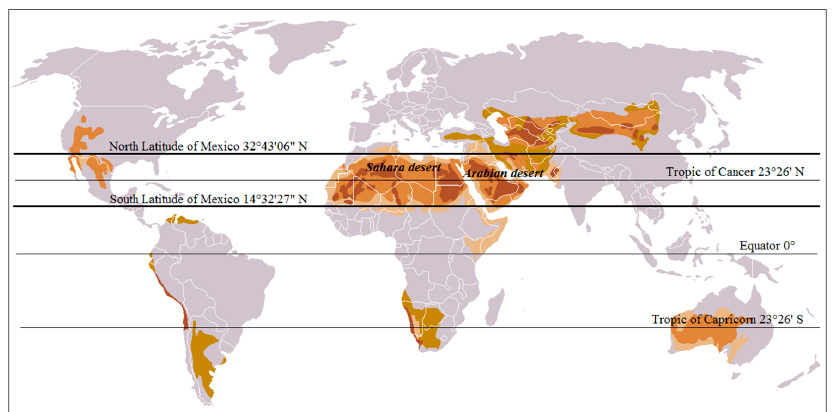
Figure 3. Geographical location and political distribution in the Mexican Republic.